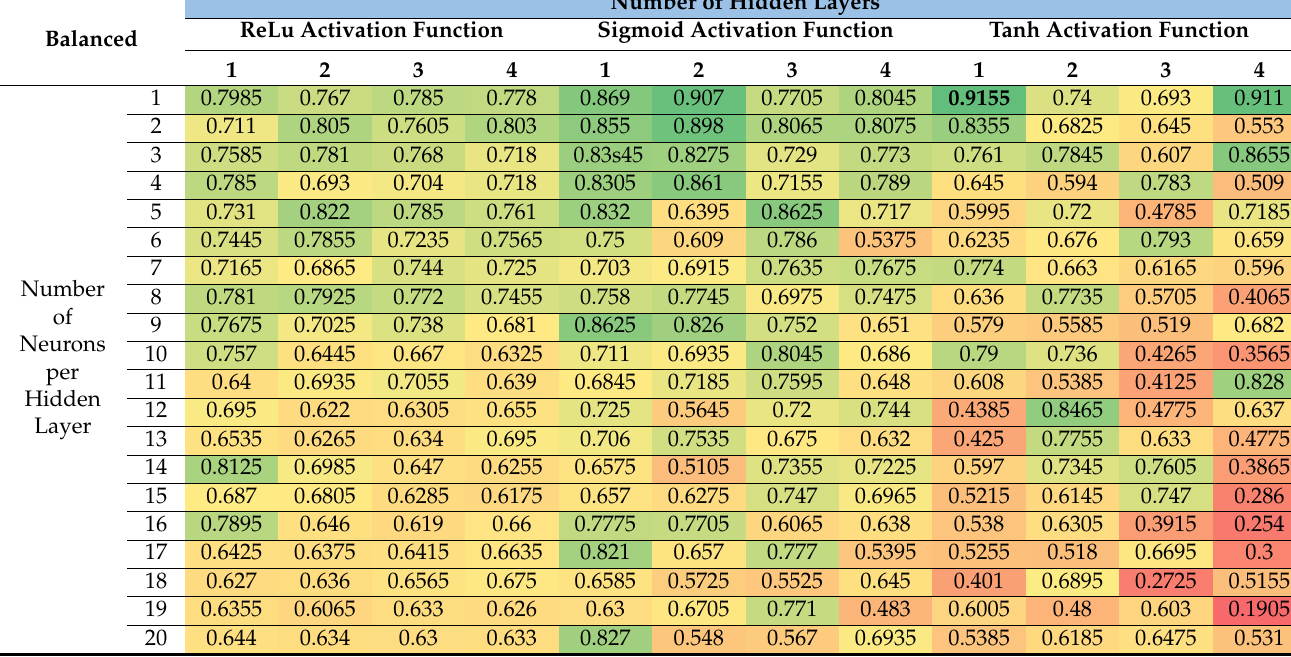
Table 4. R 2 values of the testing set for every ANN in the prediction of both the OMC and MDD.